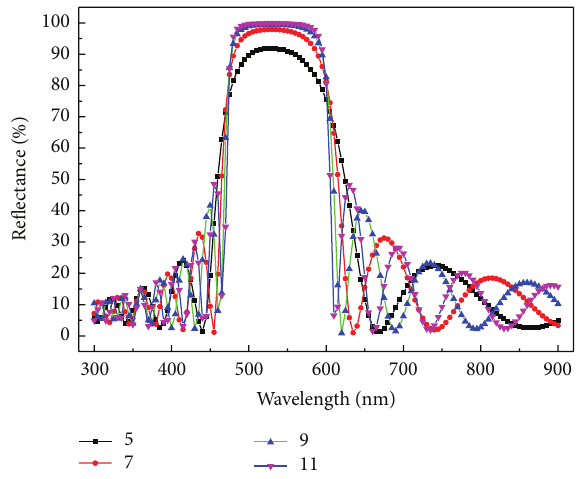
Figure 2: Reflective spectrum of 5, 7, 9, and 11 periodic dielectric multilayer.